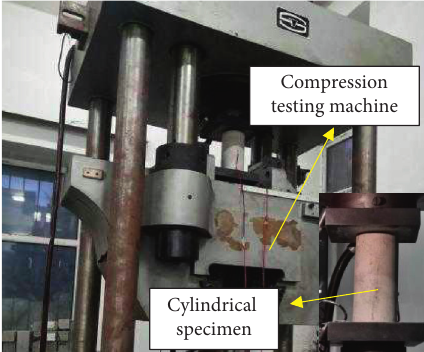
Figure 8: Axial compression test.